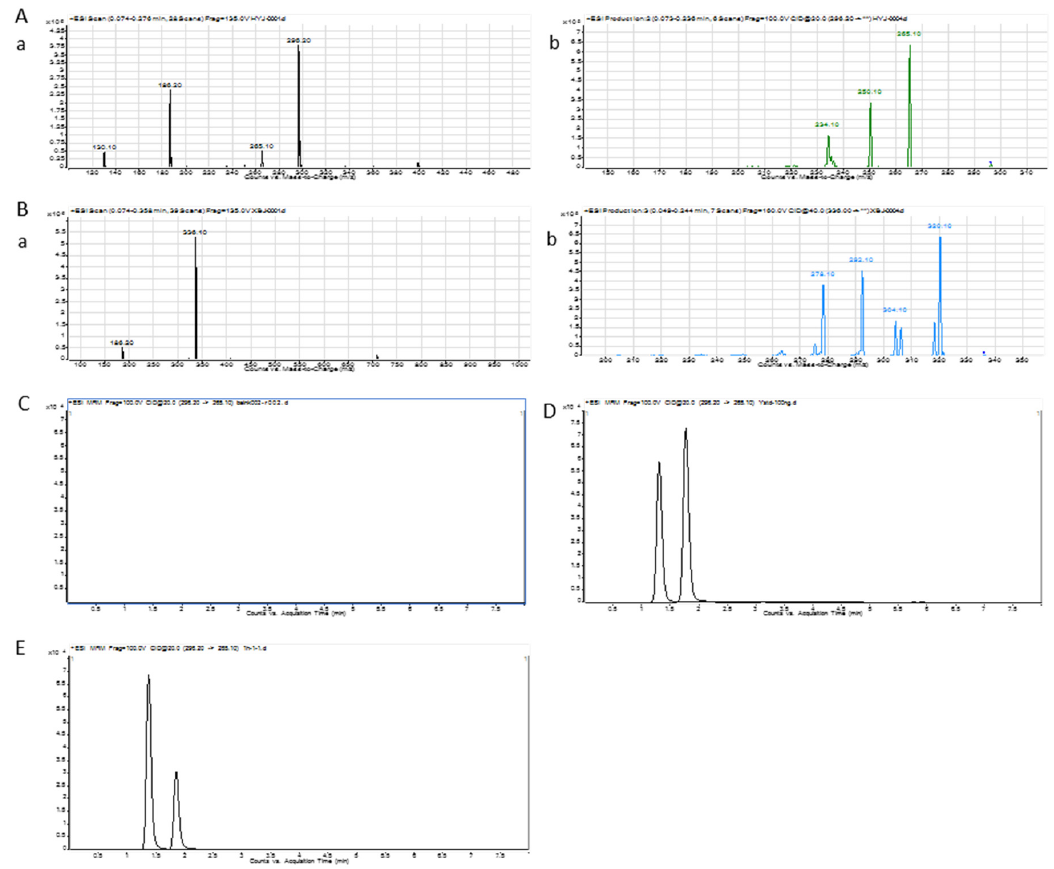
Figure 6. UPLC/MS/MS ion chromatogram of nuciferine ( A ) a.) Total ion chromatogram b.) Product ion chromatogram. UPLC/MS/MS ion chromatogram of berberine hydrochloride (BER) ( B ) a.) Total ion chromatogram b.) Product ion chromatogram. Rat blank plasma ( C ). Rat plasma was added with the corresponding standard. ( D ) Blood sample with administration of BER ( E ), 1. nuciferine; 2. BER.